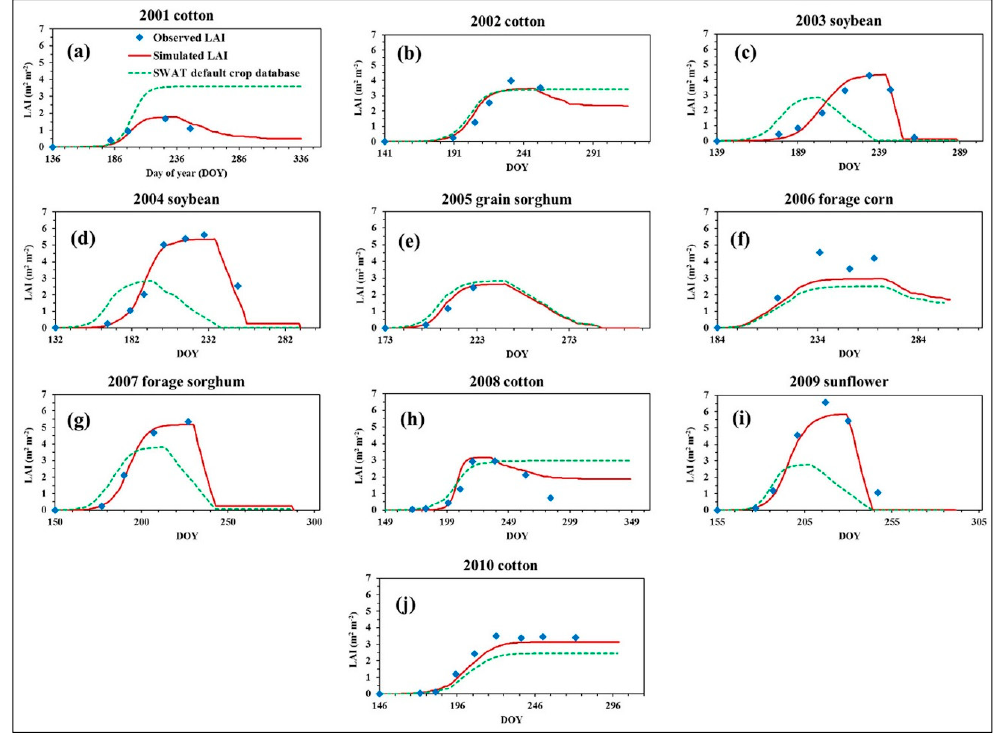
Figure 1. Simulated vs. measured leaf area index (LAI) values for crops under the irrigated lysimeter field from 2001 to 2010.